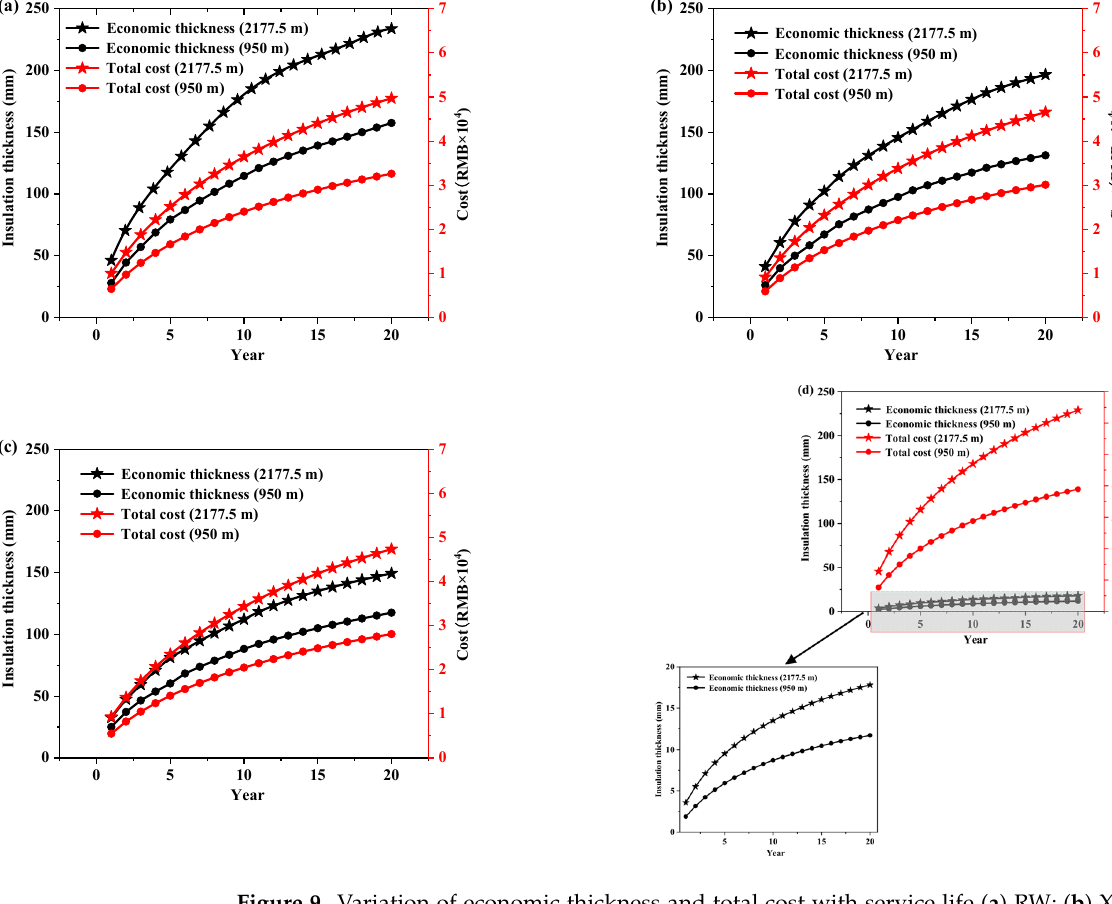
Figure 9. Variation of economic thickness and total cost with service life ( a ) RW; ( b ) XPS; ( c ) PU; ( d ) HVIP.